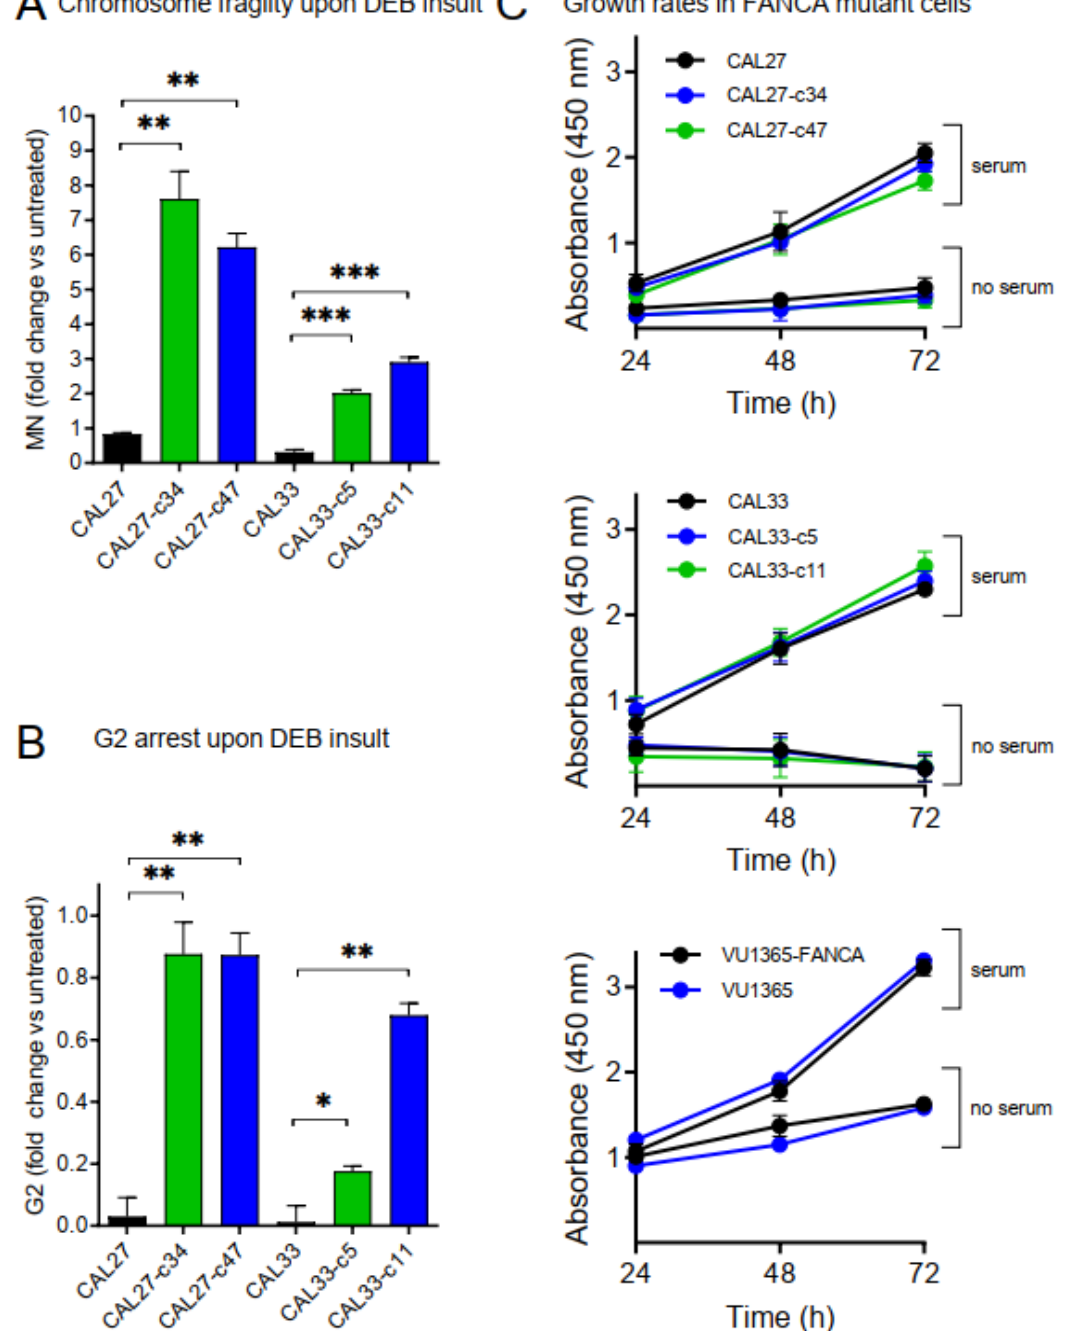
Figure 4. ( A ) Chromosome fragility analyzed by the micronucleus (MN) test. Cells were treated with diepoxybutane (DEB), kept in culture at for least one population doubling, and MN were quantified with flow cytometry. FANCA -edited clones displayed increased MN formation and therefore chromosome fragility. Data are means ± SEMs from three independent experiments, each one in duplicate. ( B ) Cells in G2 phase of the cell cycle were quantified upon DEB insult. FANCA -edited clones arrested in G2, as expected for dysfunctional FA pathway. Data are means ± SEMs from three independent experiments, each one in duplicate. ( C ) HNSCC cells were seeded and maintained in culture with (serum) or without (no serum) 10% FBS for 24, 48, and 72 h. Cell viability was measured using XTT assay and absorbance at 450 nm. FANCA mutation does not affect growth rate in HNSCC cells. p -values were calculated upon a T-Student test for independent samples ( A , B ) or upon a two-way ANOVA test ( C ). *: p -value ≤ 0.05; **: p -value ≤ 0.01; ***: p -value ≤ 0.001.